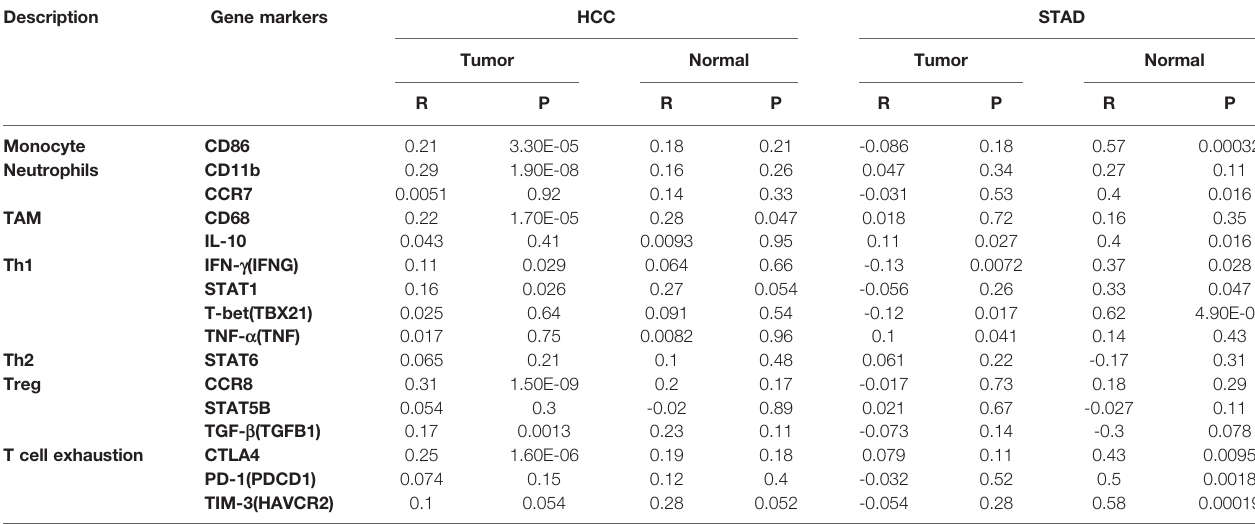
TABLE 4 | Correlation analysis between ASRGL1 and markers of immune cells in GEPIA.